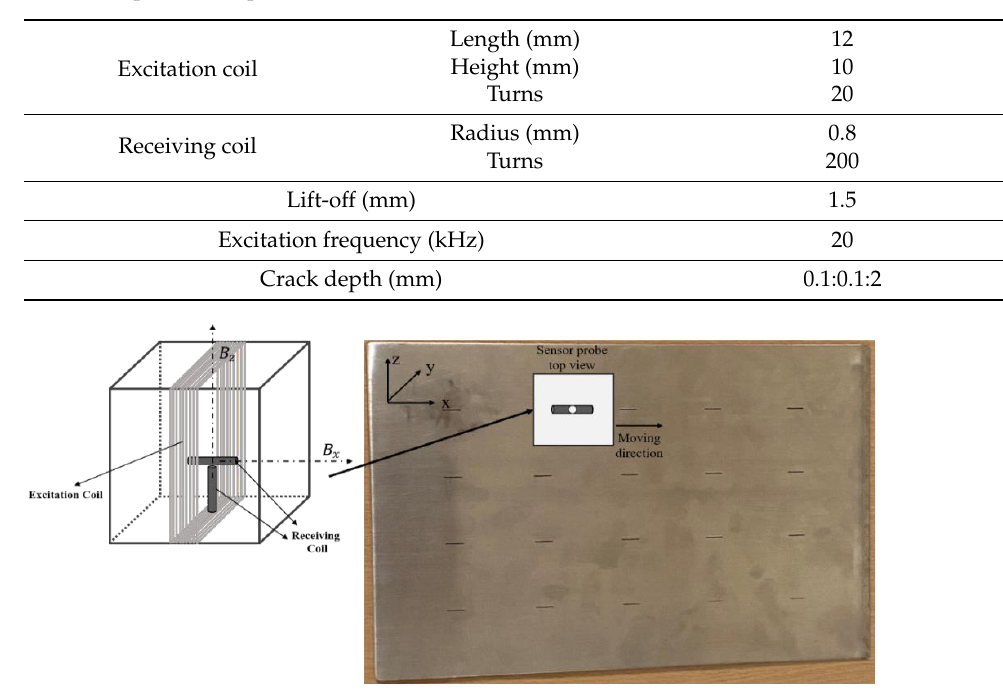
Figure 8. The trajectory of the sensor probe.